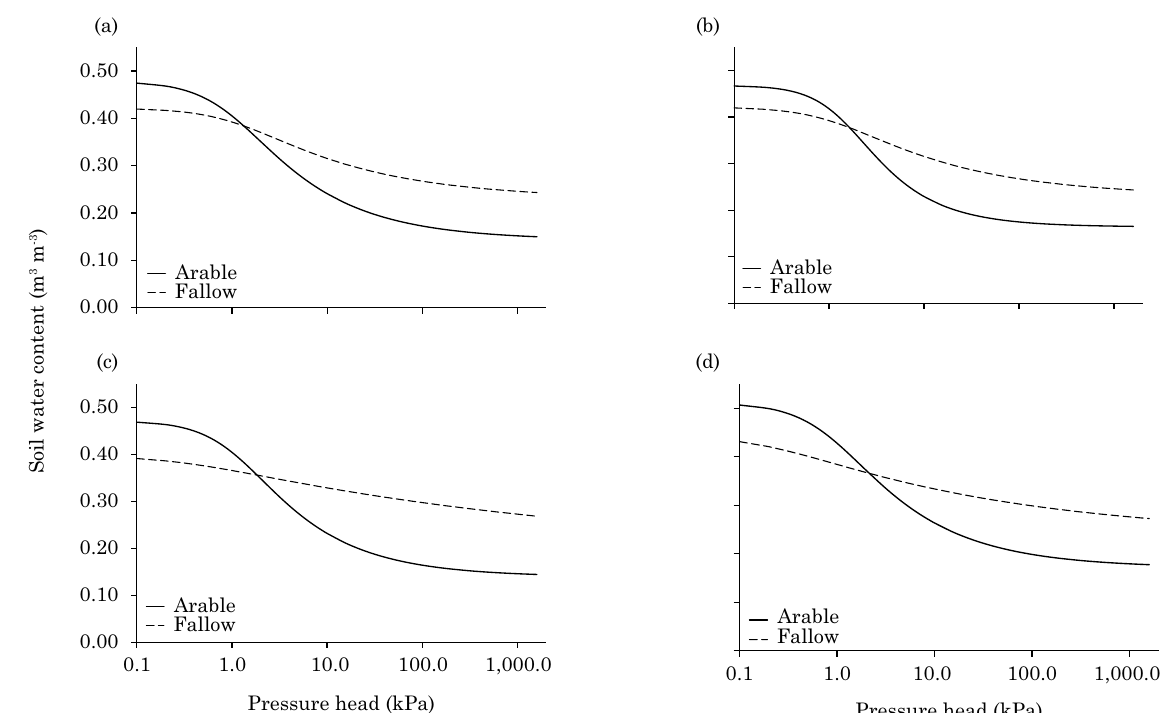
Figure 3. Soil water retention curves (SWRCs) for soil under the continuous arable cropping system and natural bush fallow system for depths D1 (0-5 cm) (a), D2 (5-10 cm) (b), D3 (10-15 cm) (c), and D4 (15-20 cm)